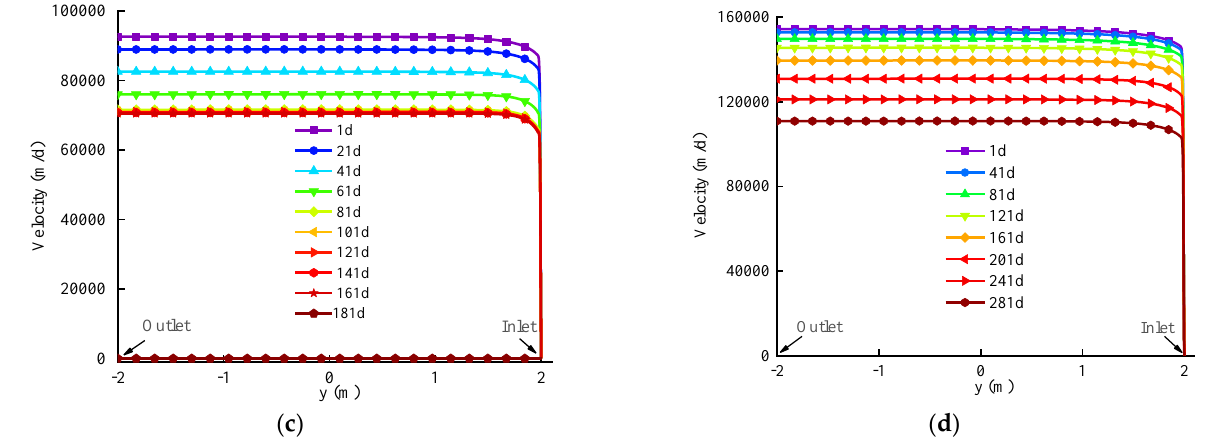
Figure 11. Variations in interfacial fracture flow velocity of fractured rock mass with fracture aper- ture of 5 mm during freezing under different groundwater seepage velocities: ( a ) v = 0.1 m/d; ( b ) v = 0.3 m/d; ( c ) v = 0.5 m/d; ( d ) v = 1 m/d.